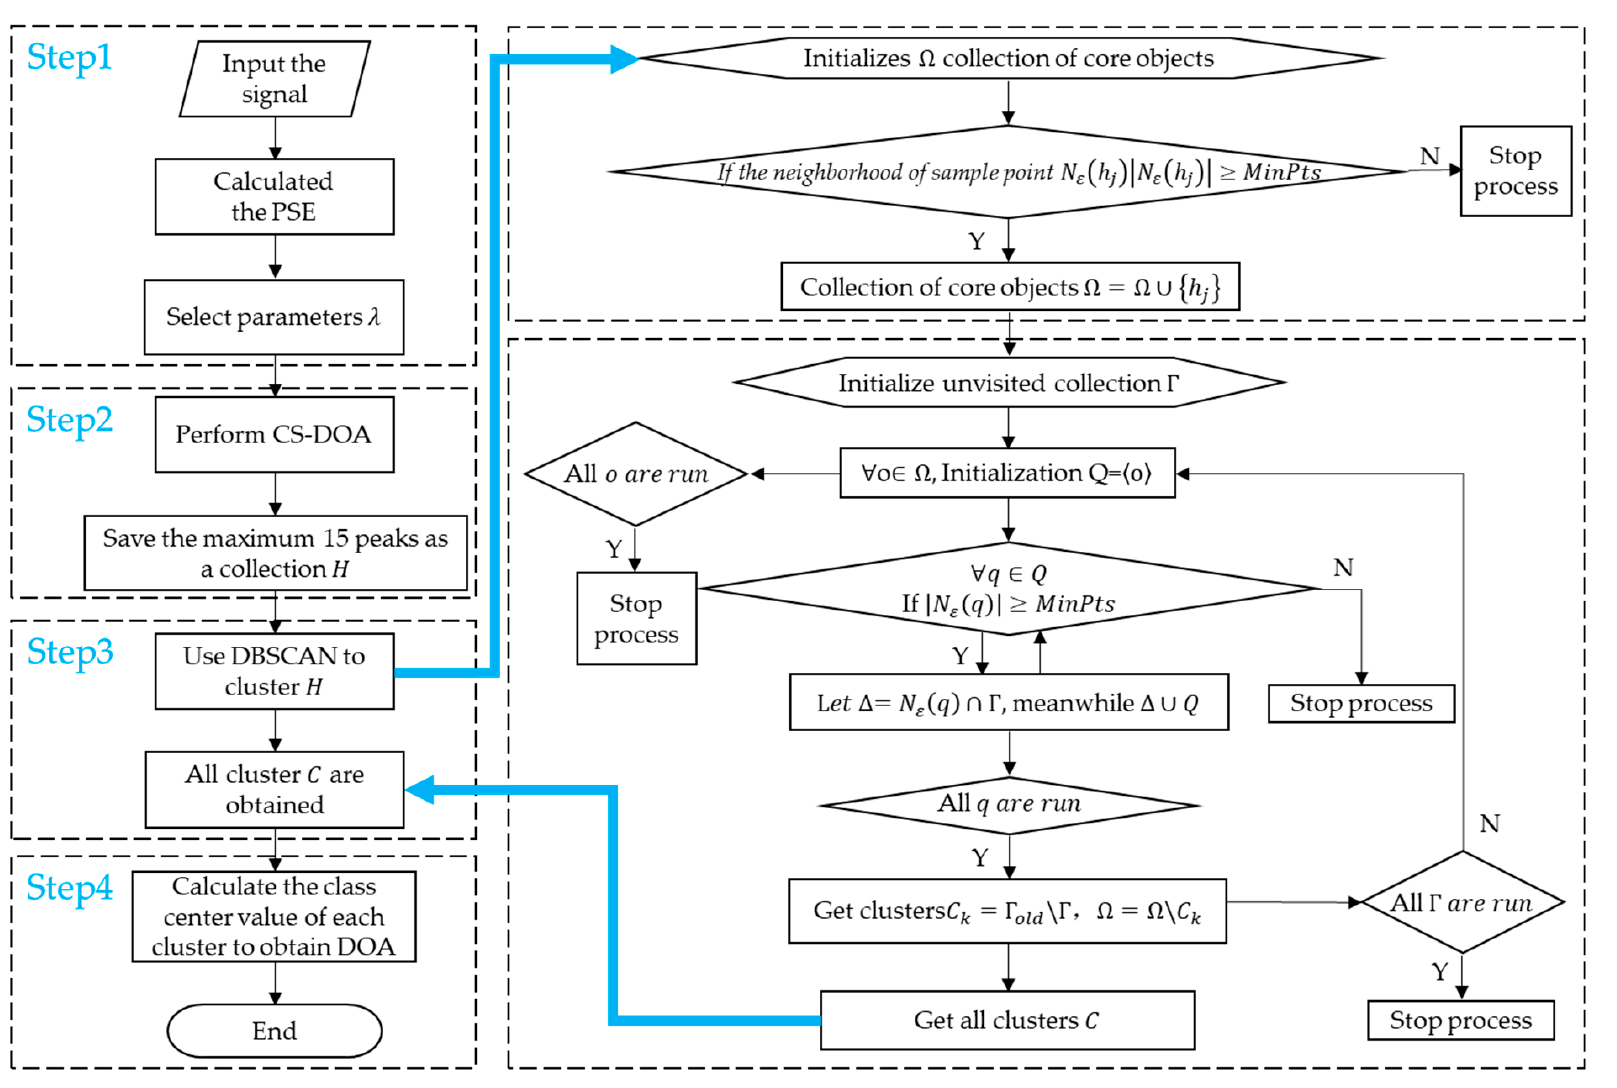
Figure 7. Flow chart of CS-DOA-DBSCAN algorithm.